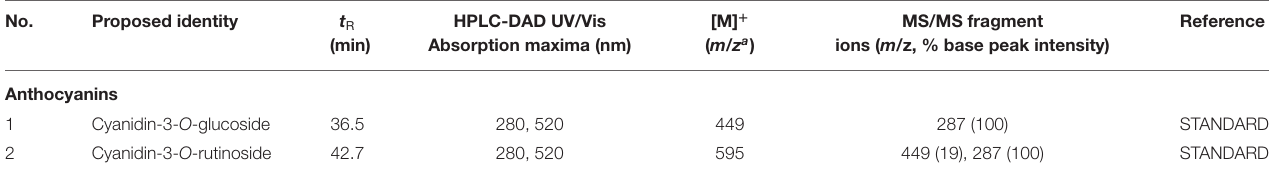
TABLE 3 | HPLC retention times ( t R ), UV/Vis and ESI-MS spectral data of anthocyanins from pooled samples of coffee peels and pulp.